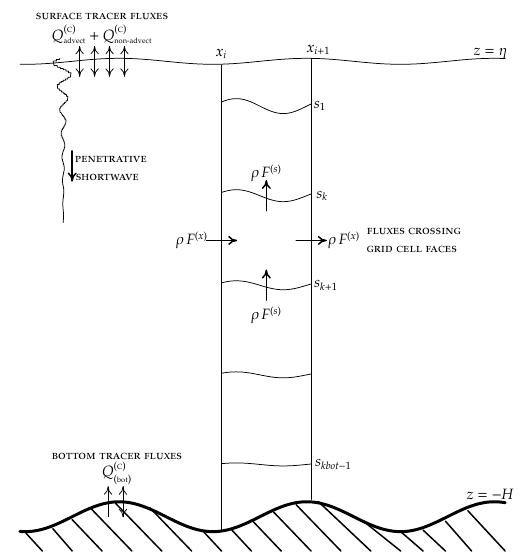
Figure L1. A longitudinal–vertical slice of ocean fluid from the surface at z = η(x,y,t) to bottom at z = − H(x,y) , along with a representative column of discrete grid cells (a latitudinal–vertical slice is analogous). Ocean models used for large-scale climate stud- ies assume the horizontal boundaries of a grid cell at x i and x i + 1 are static, meaning that the horizontal cross-sectional area is time- independent. In contrast, the vertical extent, defined by surfaces of constant generalized vertical coordinates s k and s k + 1 , are generally time-dependent (e.g. z ∗ surfaces, pressure surfaces, isopycnal sur- faces, sigma surfaces). A general tracer flux ρ F (e.g. advective or subgrid-scale flux) is decomposed into horizontal and dia-surface components, with the convergence of these fluxes onto a grid cell determining the evolution of tracer content within the cell. Amongst the fluxes crossing the ocean surface, the shortwave flux penetrates into the ocean column as a function of the optical properties of sea- water (e.g. Manizza et al., 2005). This figure is based on Fig. 1 of Griffies and Treguier